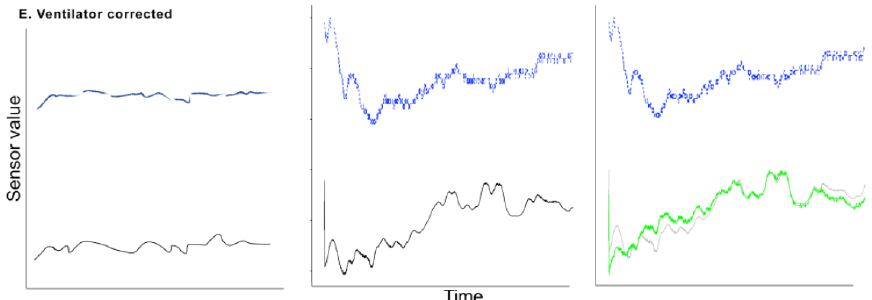
Figure 2. Noise inducing variables in continuous breath signals of ventilated intensive care unit patients ( A – E ). From left to right, Panel 1: schematic representation of type of noise; Panel 2: example of the noise in the data, where blue dashed lines indicate humidity in ( B ) and an example of a ventilator signal (end tidal CO 2 ) in ( E ); and Panel 3: example after correction for the noise type, where green line indicates sensor signal after noise reduction step, red line indicates discarded signal values. In ( D ), the grey line represents the initial values of one of the eNose sensors, the green line corresponds to the LOESS smoother and the red dots are values that are above the set threshold and are therefore considered outliers.